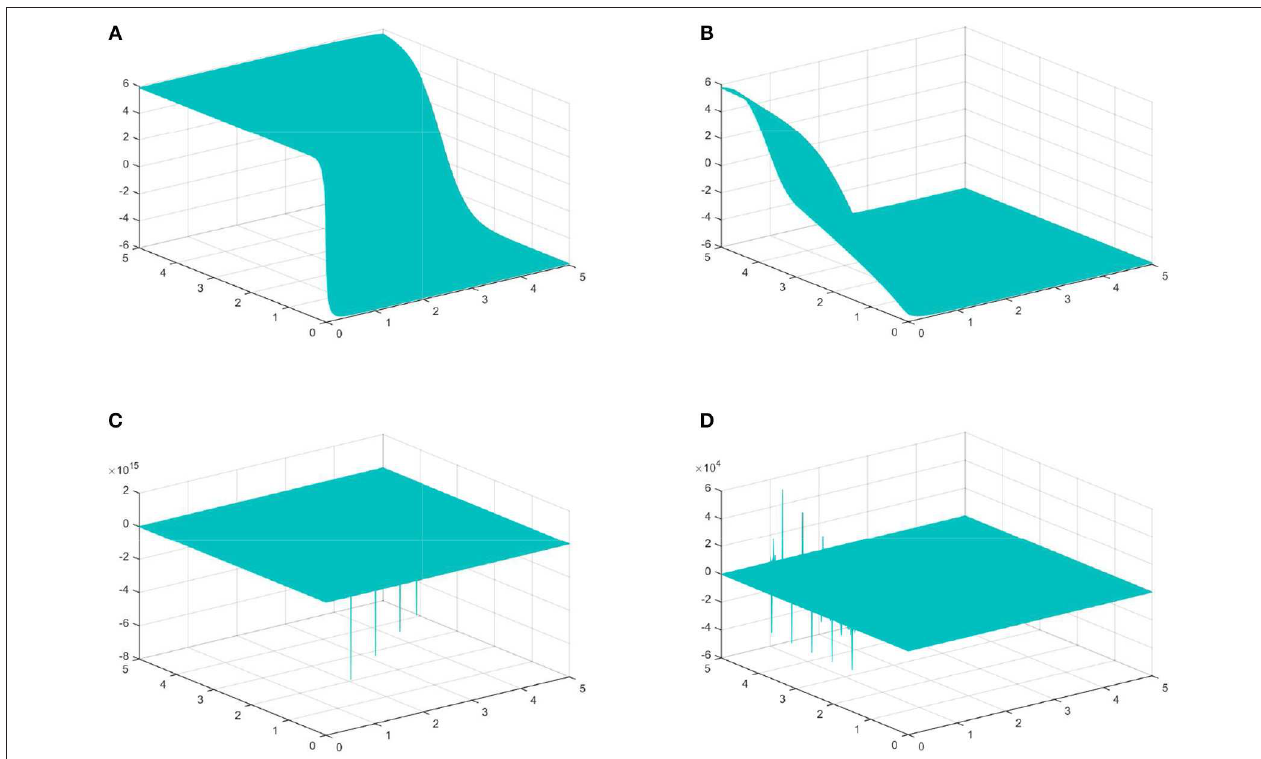
0.5 for (27). (C) M-truncated =